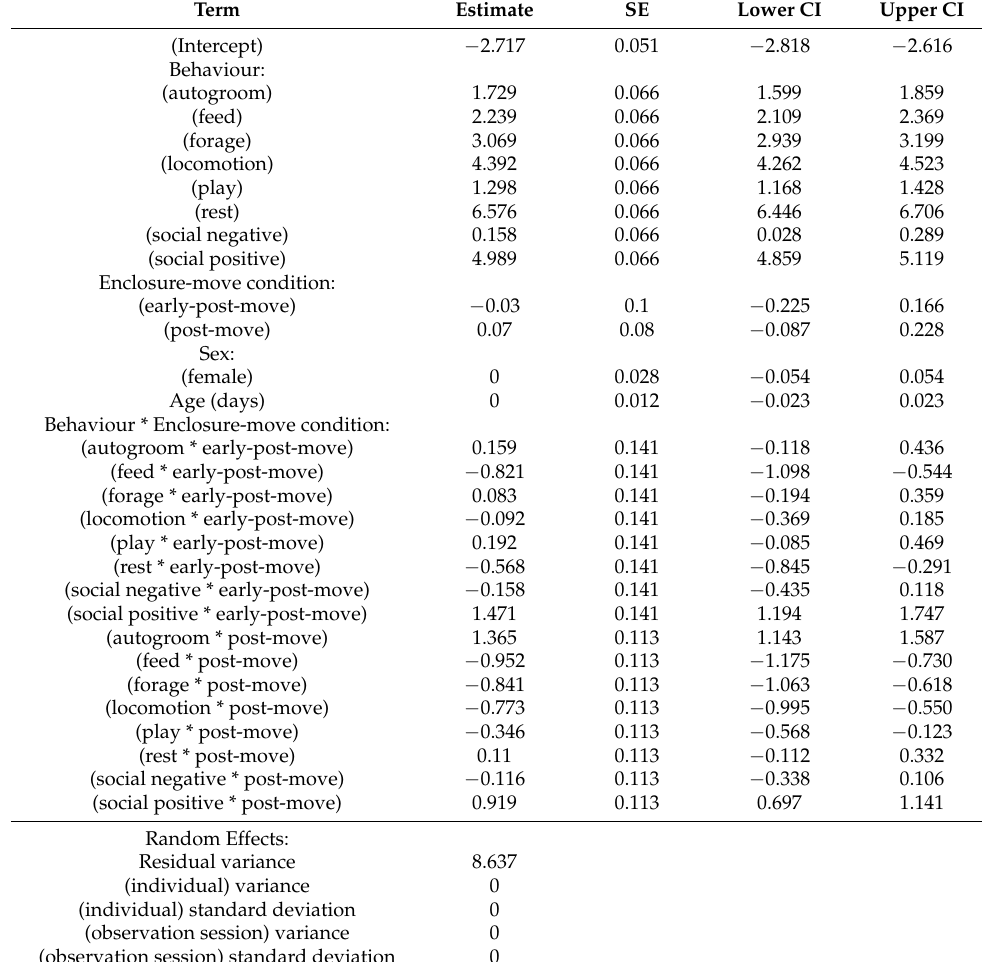
Table A6. Model 2 summary output: Crested macaque activity